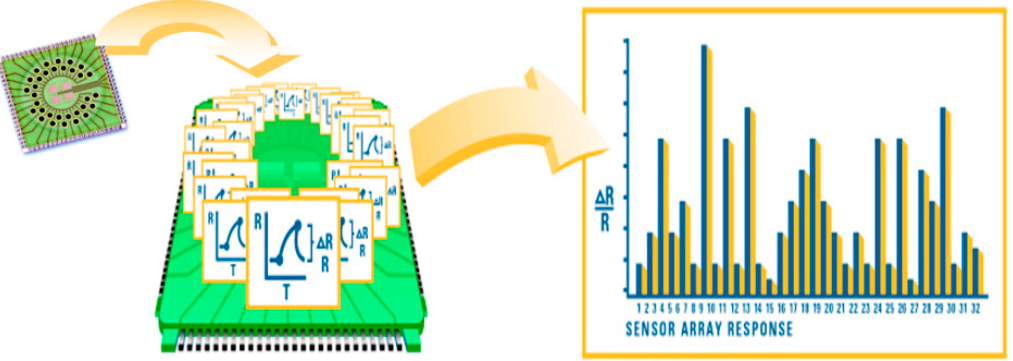
Figure 2. Working principle of Cyranose 320: it is based on a nano-composite array of 32 organic polymer sensors. If exposed to VOC combinations, the polymers swell, thereby modifying their electrical resistance. Raw data are registered as the increase in resistance of any single sensors and the combination of all signals results in a “breathprint”.